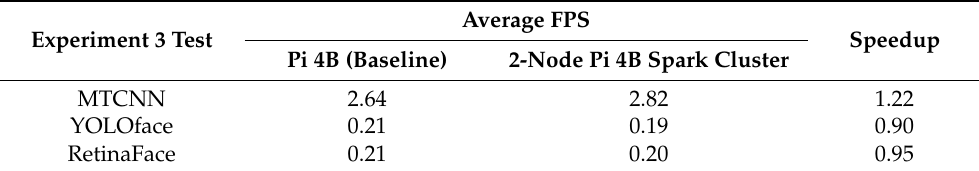
Table 9. Comparison of average FPS and speedup between a single Pi 4B and a 2-node Pi 4B cluster for Experiment